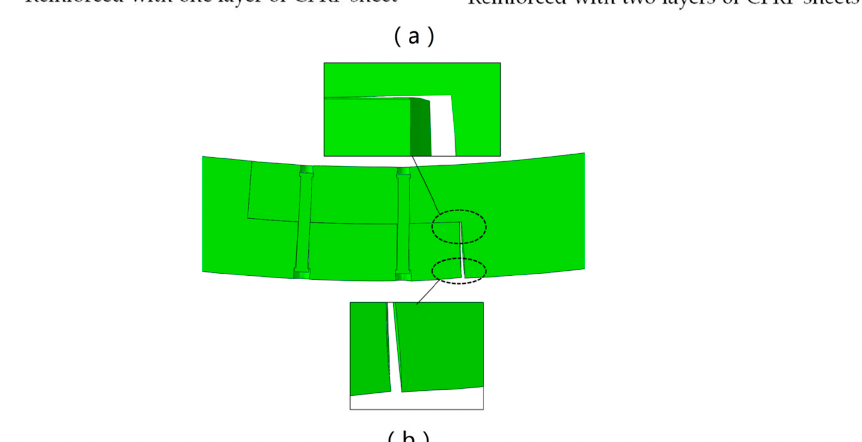
Figure 13. Stress contour and deformation of the lap joint. ( a ) Stress contour; ( b ) deformation.